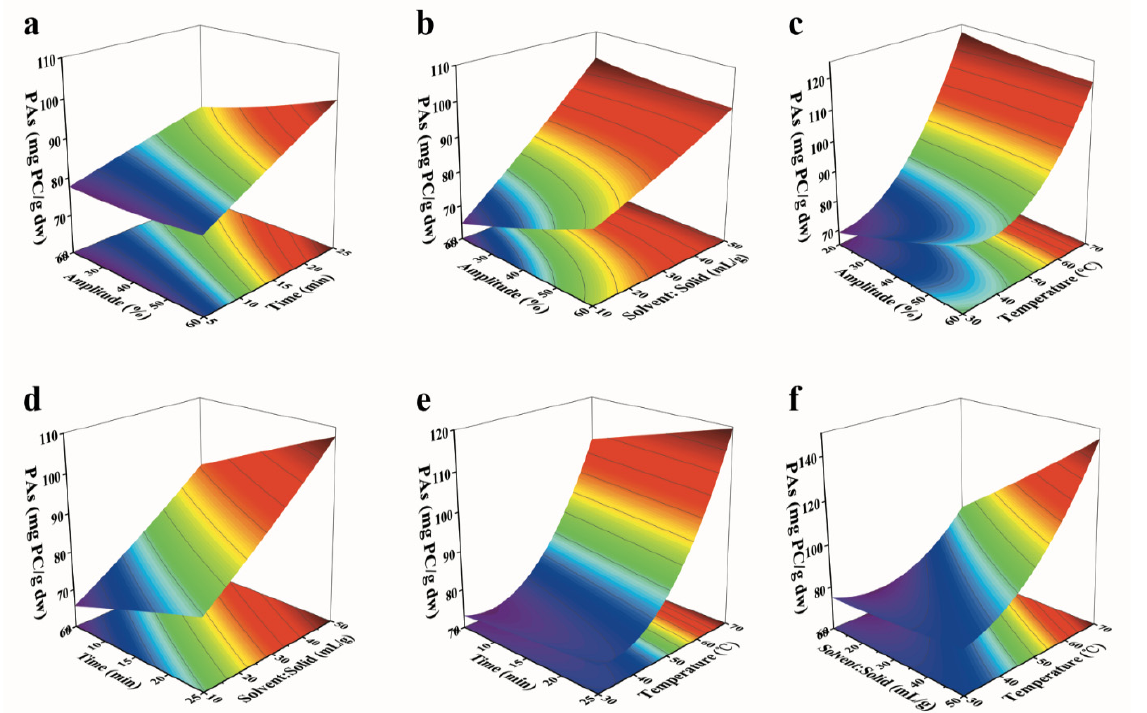
Figure 4. Response surface methodology (RSM) for the ultrasound-assisted extraction (UAE) of extracted yield of proantho- cyanidins (PAs) from kiwi leaves with respect to ultrasonic amplitude ( X1 ); extraction time ( X2 ); solvent to solid ratio ( X3 ); and extraction temperature ( X4 ). ( a ) RSM between amplitude and time; ( b ) RSM between amplitude and solvent to solid ratio; ( c ) RSM between amplitude and temperature; ( d ) RSM between time and solvent to solid ratio; ( e ) RSM between time and temperature; ( f ) RSM between solvent to solid ratio and temperature.